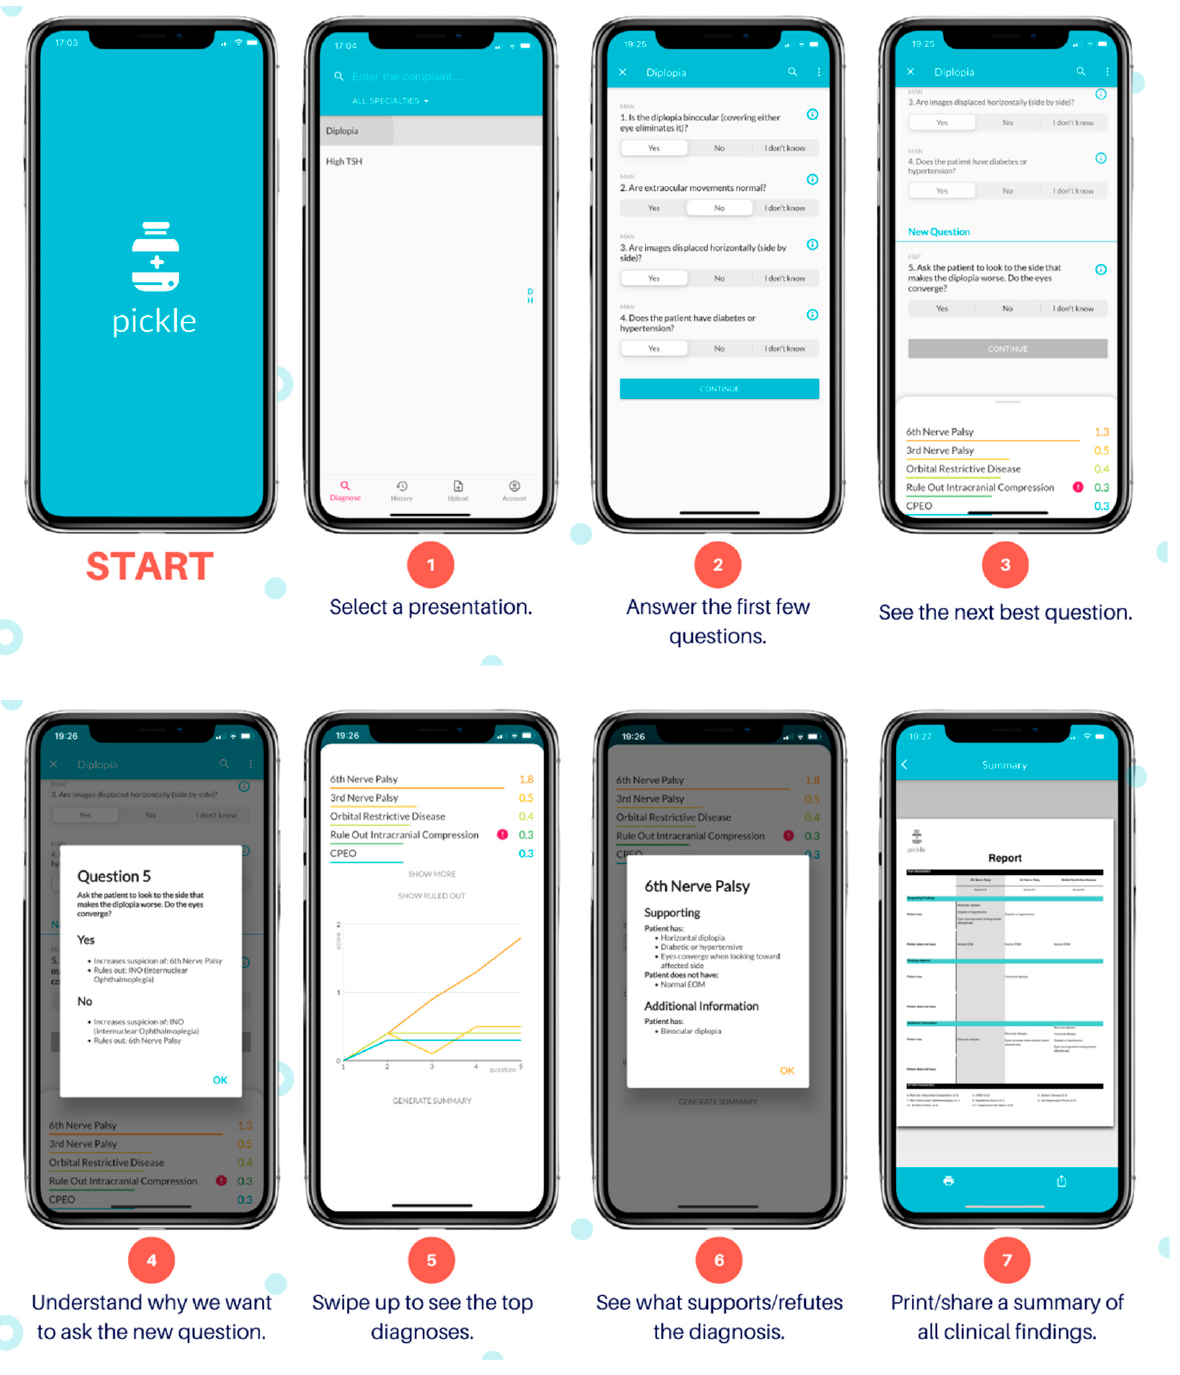
Figure 1. Pickle app user interface.